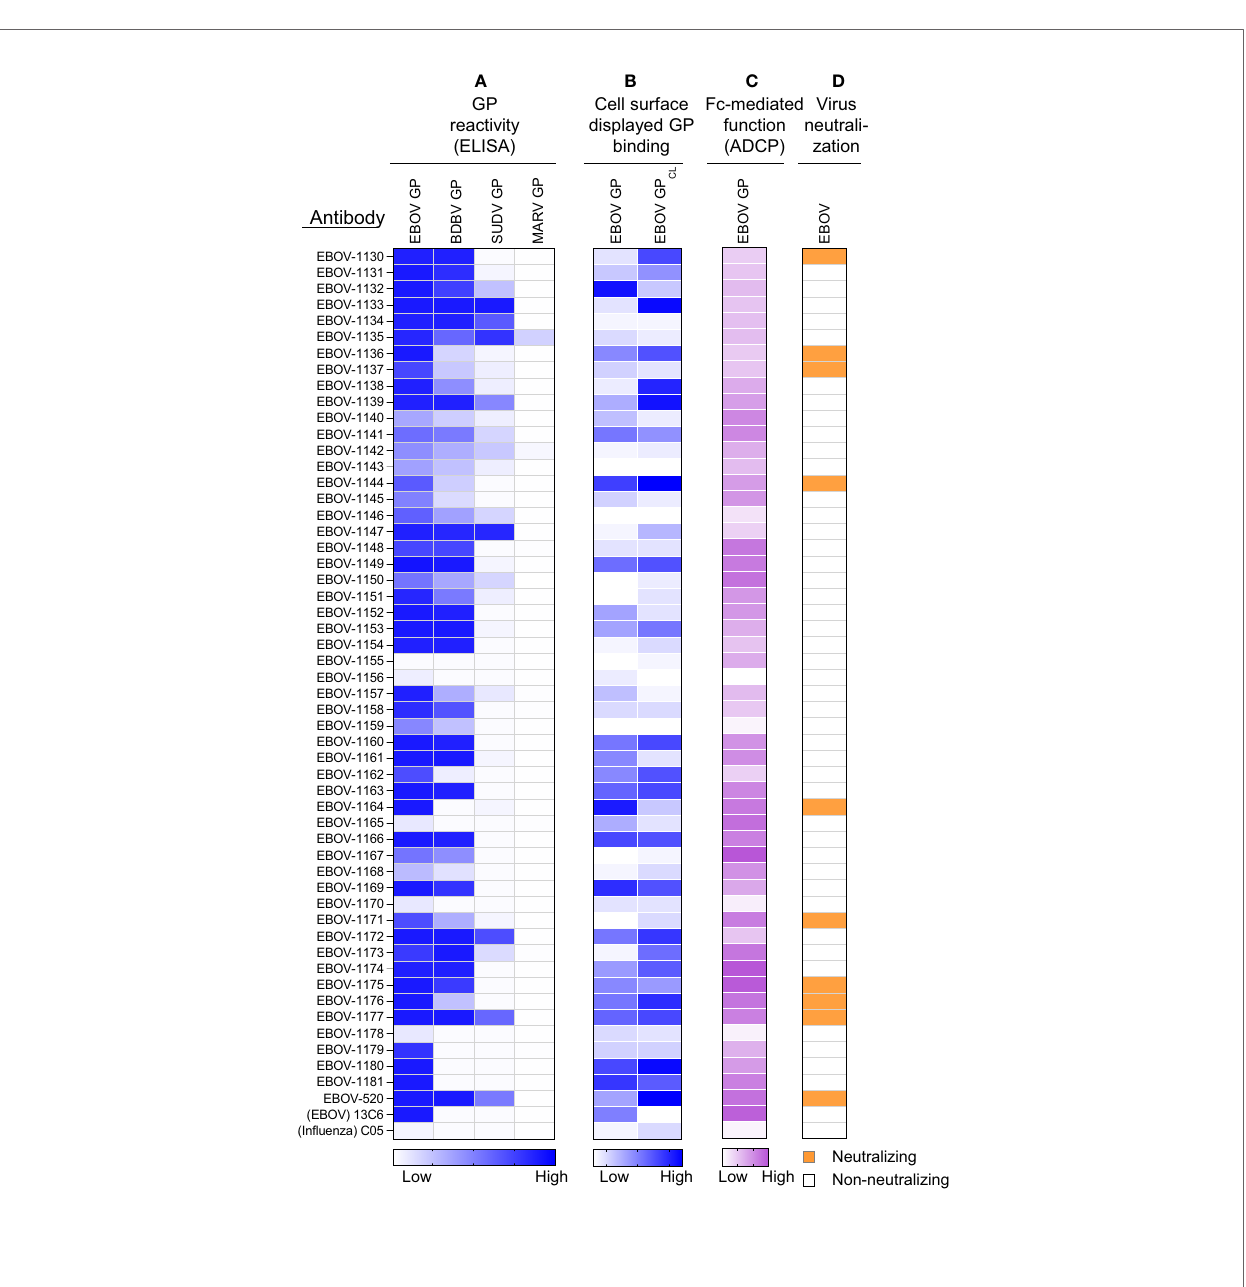
FIGURE 3 | Reactivity and functional activity of 52 monoclonal antibodies identi fi ed in plasma by proteomic studies. Antibody sequences that were present in both genomic and proteomic repertoires were determined, generated as synthetic antibody-encoding cDNA in mammalian immunoglobulin IgG expression vectors, and produced as recombinant IgG1 using transiently-transfected CHO cells and a micro-scale expression protocol. Micro-scale puri fi ed antibodies were assessed for binding and functional activities at a single dilution (see Methods and Table S4 ). The broadly reactive neutralizing mAb EBOV-520, and recombinant forms of EBOV GP monospeci fi c mAb 13C6 and in fl uenza A hemagglutinin-speci fi c mAb C05 were used as controls. (A) MAb binding to each of four GP proteins, including EBOV, BDBV, SUDV, and MARV GP. The fi gure shows a heatmap for binding of 52 mAbs expressed recombinantly, representing optical density (O.D.) values measured at 450nm for each antigen (range, 0.1 – 3.7). White indicates a lack of detectable binding, while blue indicates moderate binding and darker blue indicates higher binding. (B) MAb binding to Jurkat-EBOV or Jurkat-EBOV GP CL cells determined by fl ow cytometric analysis. The fi gure shows a heatmap for binding of 52 tested mAbs, representing log 10 median fl uorescence values for each tested condition (range, 3.6 – 6.4). White indicates background binding, and the gradient of blue indicates moderate binding and darker blue indicates the extent of speci fi c binding. Binding of human antibody was detected using secondary goat anti-human IgG- speci fi c antibodies conjugated to phycoerythrin. (C) Antibody Fc region-mediated cellular phagocytosis activity determined using EBOV-GP-coupled fl uorescent beads and THP-1 monocyte human cell line. The fi gure shows a heatmap for binding of 52 tested mAbs, representing phagocytic score values (range, 62 to 195). (D) Screening for neutralizing antibody activity using biosafety level 4 recombinant EBOV encoding enhanced green fl uorescent protein (eGFP). Green indicates neutralizing activity (>30% virus neutralization at the single mAb dilution tested), and white designates lack of neutralizing activity (<30% virus neutralization at the single mAb dilution